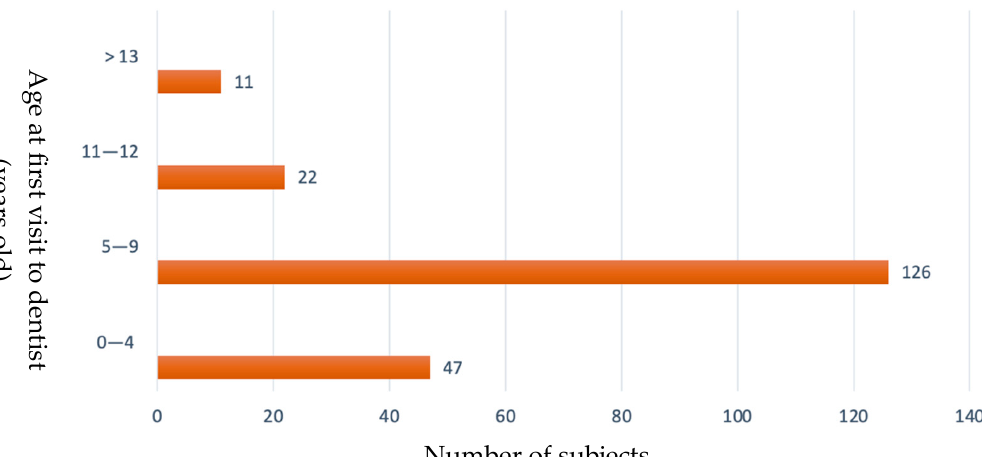
Figure 2. Age at first visit to dentist.